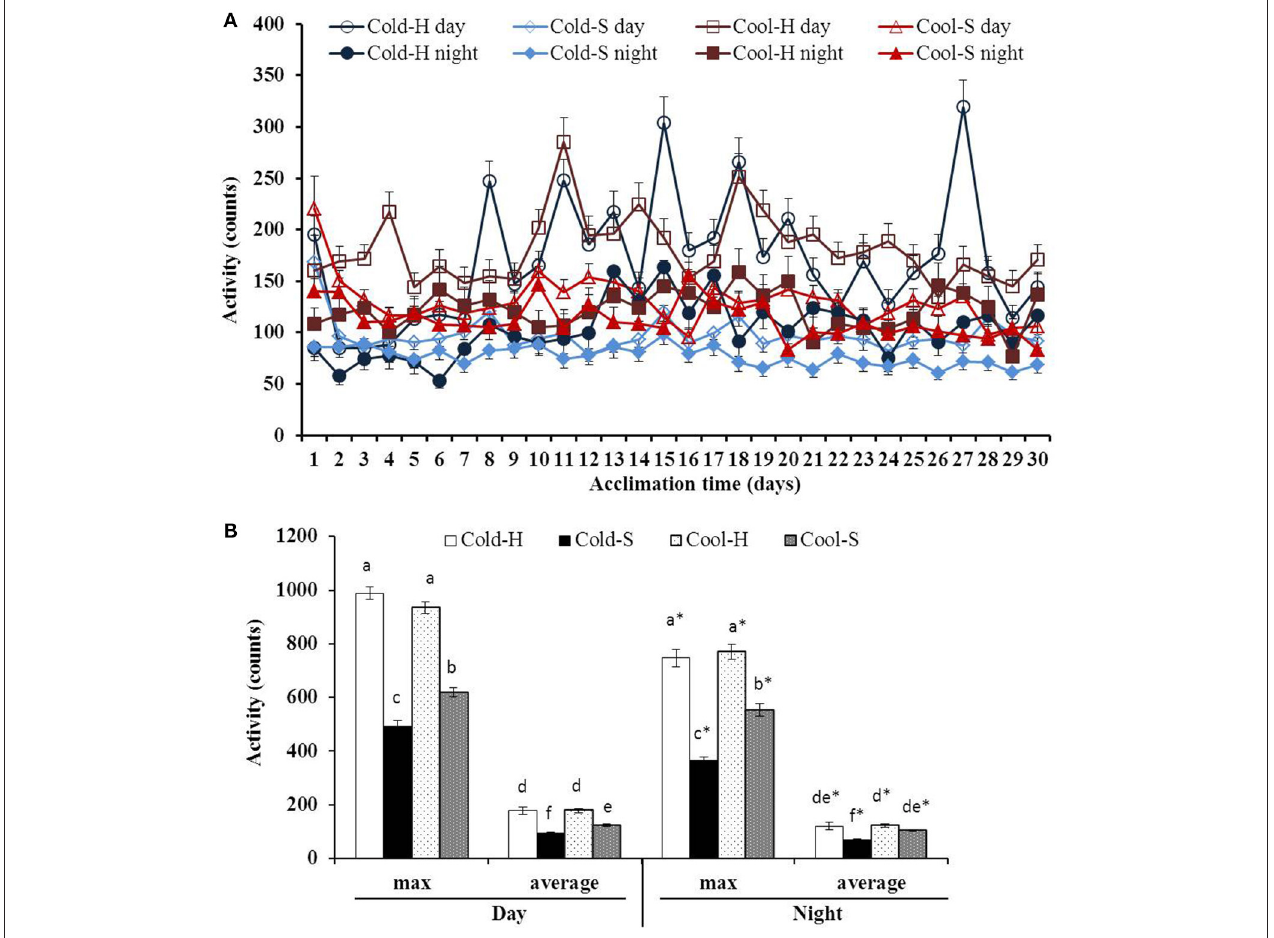
FIGURE 3 | Daytime and nighttime activities during acclimation (A) and differences in maximum and average activity (B) of voles from different experimental groups. Different letters indicate significance among groups; *(star) indicates differences between daytime and nighttime